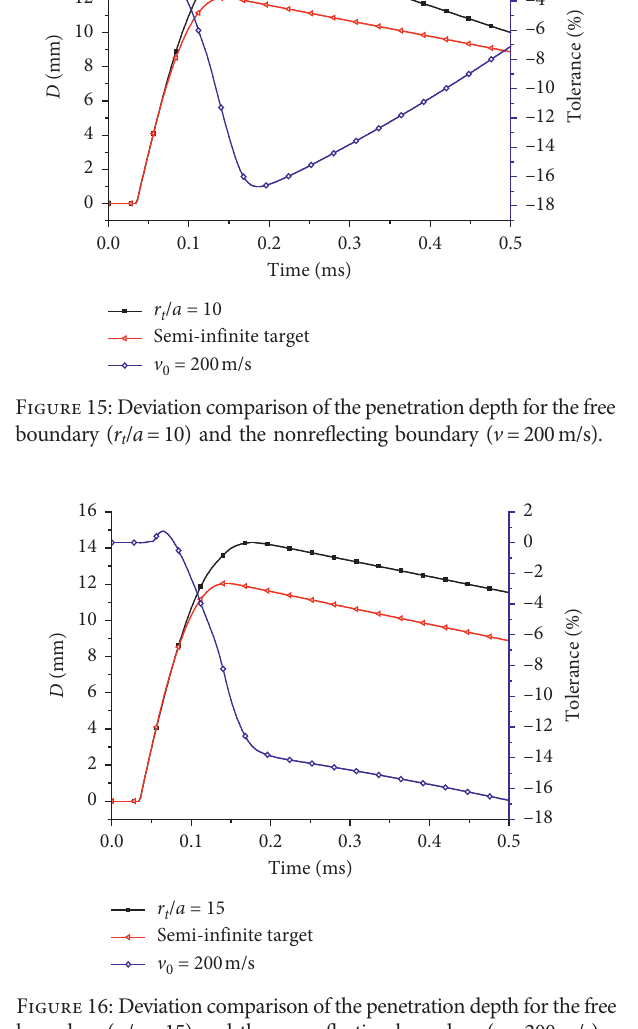
Figure 17: Deviation comparison of the penetration depth for the free boundary ( r t / a � 20) and the nonreflecting boundary ( v � 300m/s).